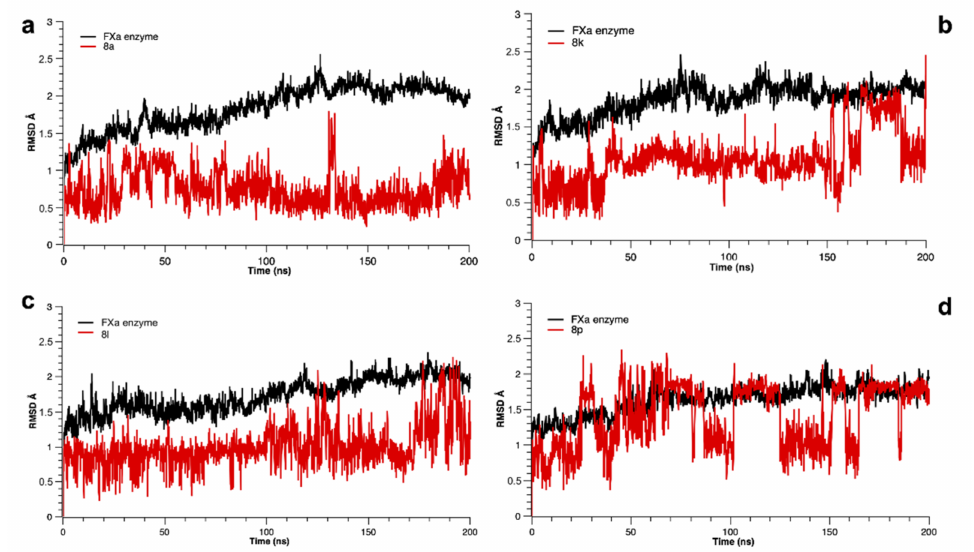
Figure 5. Root mean square deviation (RMSD) as a function of simulated times for the complexes formed between FXa and the active compounds 8a , 8k , 8l and 8p (indicated by a – d ,